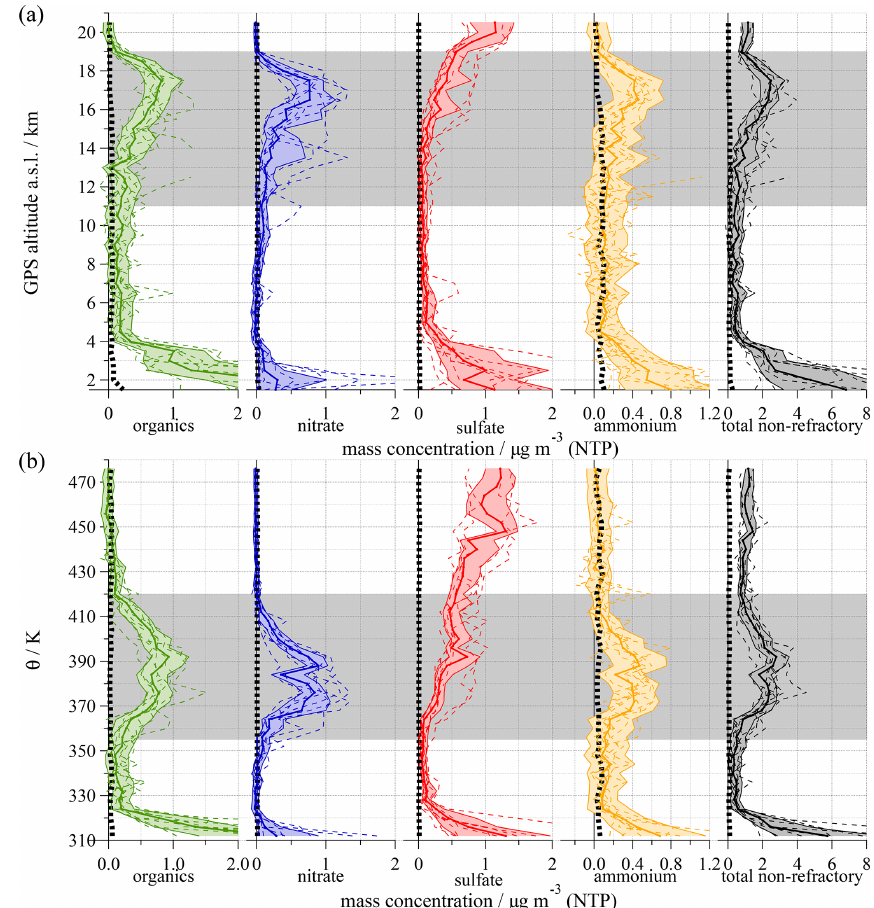
Figure 2. ERICA-AMS mass concentrations of particulate organics (green), nitrate (blue), sulfate (red), and ammonium (orange) as a function of (a) GPS altitude and (b) potential temperature θ . The thick lines and the shaded areas represent the medians and 25th/75th percentiles in the corresponding altitude or θ bin of the entire StratoClim aircraft campaign in 2017. The dashed lines represent the medians of each individual research flight. The right panel displays the sum of all species measured by the ERICA-AMS (black). The shaded background indicates the approximate altitude range of the ATAL. For each altitude bin, the detection limit is displayed as a dotted line close to the ordinate. Concentrations in the BL can exceed the displayed